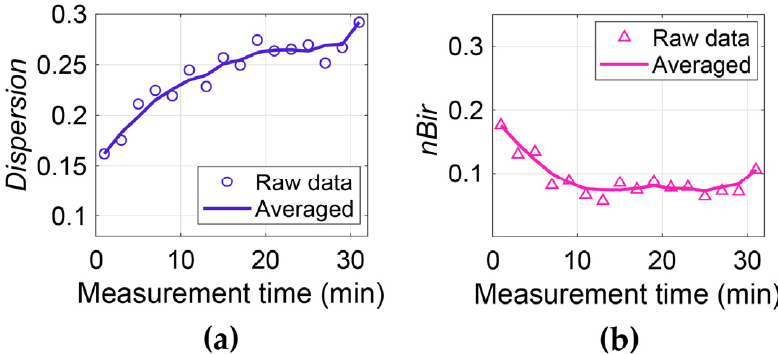
Figure 16. ( a ) Dispersion and ( b ) n birefringence of one subject. The symbols are the raw data and the solid curves are the moving average of every 5 data [53].